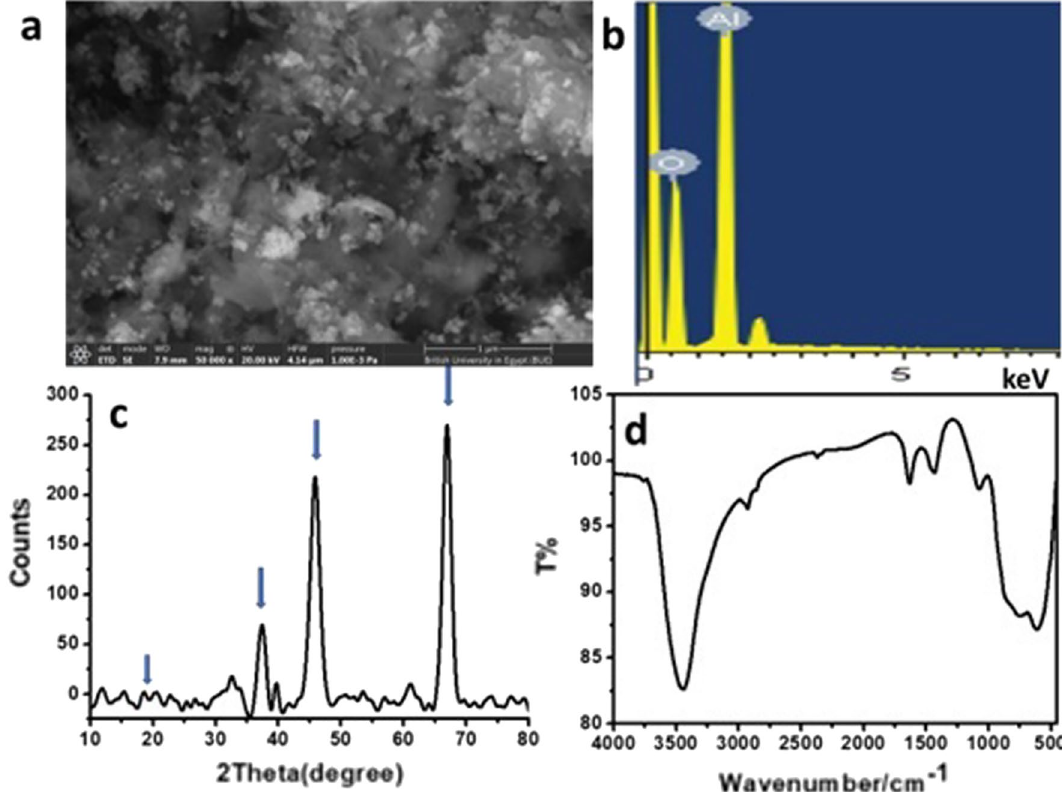
Figure 4. SEM image of the prepared Al 2 O 3 NPs ( a ), EDS ( b ) shows the composition of Al 2 O 3 NPs, XRD patterns ( c ), and FTIR spectrum ( d ),